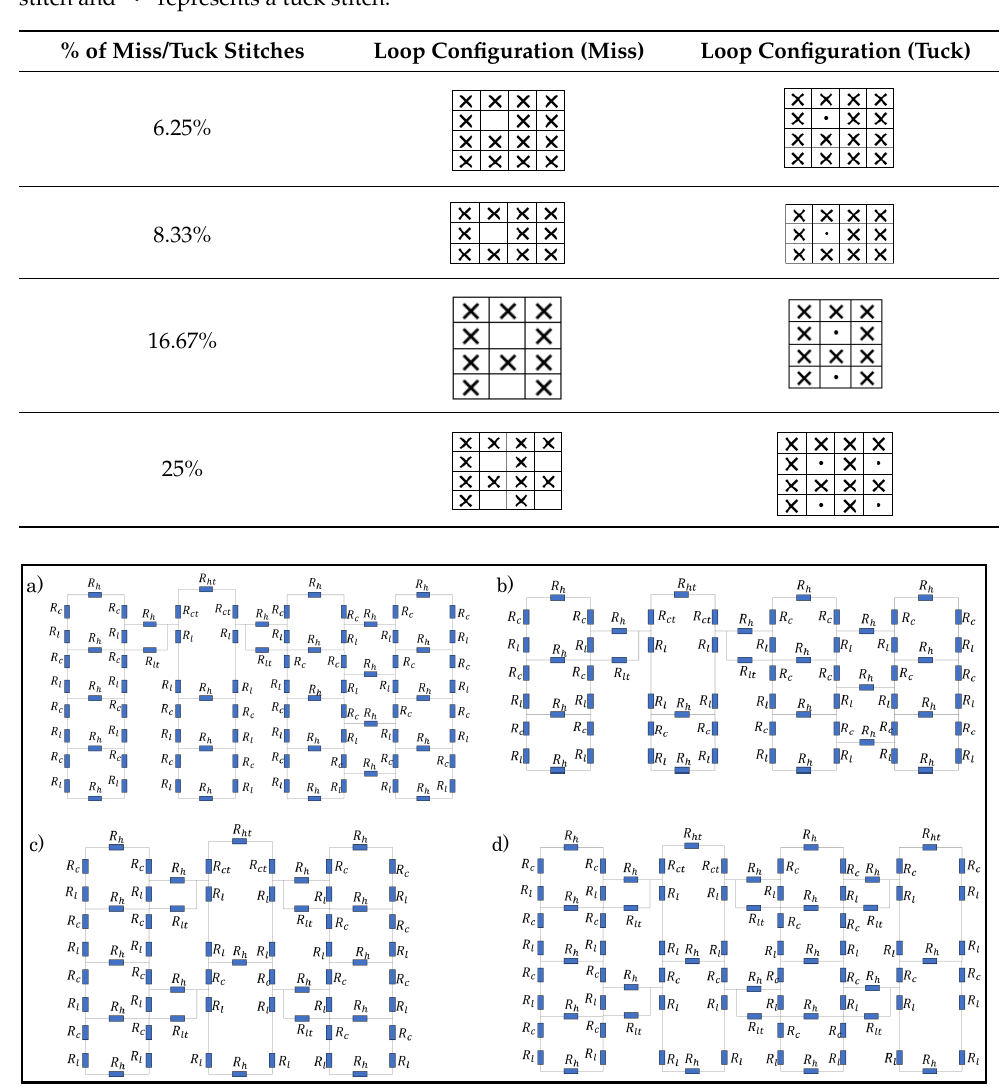
Figure 5. Unit circuit diagram of samples with tuck stitches. ( a ) 6.25% tuck stitches ( b ) 8.33% tuck stitches ( c ) 16.67% tuck stitches ( d ) 25% tuck